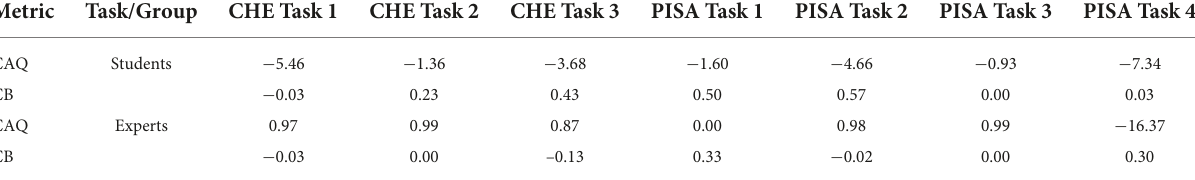
TABLE 1 Confidence related